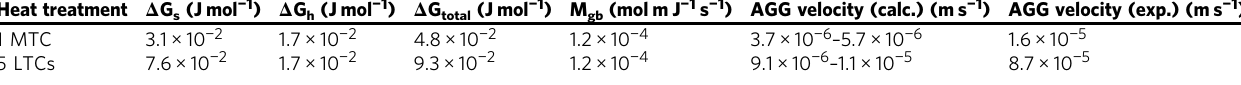
Table 2 Driving pressures, grain boundary mobility and AGG